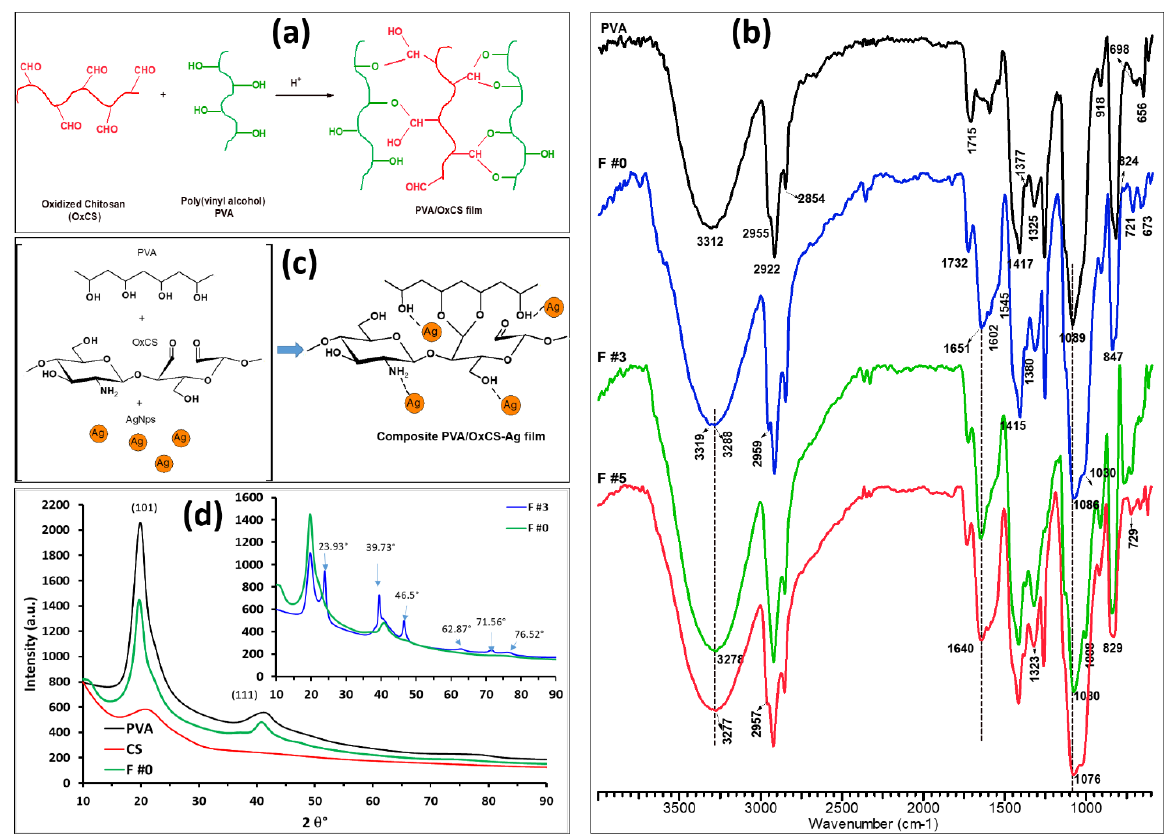
Figure 4. Schematic representation of the synthesis mechanism of pure ( a ) and composite PVA/OxCS-Ag films ( c ); FT-IR/ATR ( b ) and XRD ( d ) spectra of pure (F #0) and composite PVA/OxCS-Ag films (F #3 and F #5).